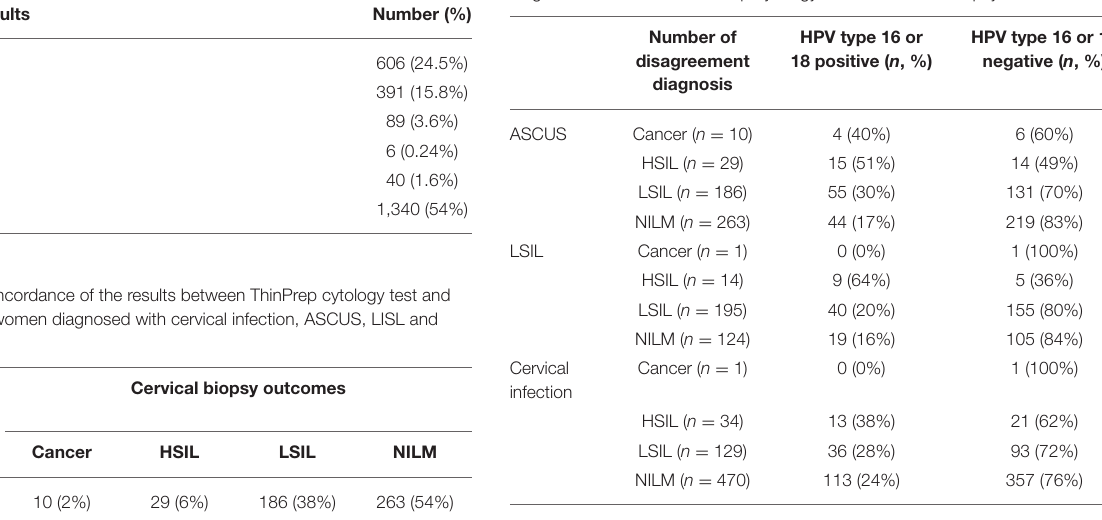
TABLE 3 | The distribution of HPV 16 or 18 positive in women with disagreement diagnosis between the ThinPrep cytology test and cervical